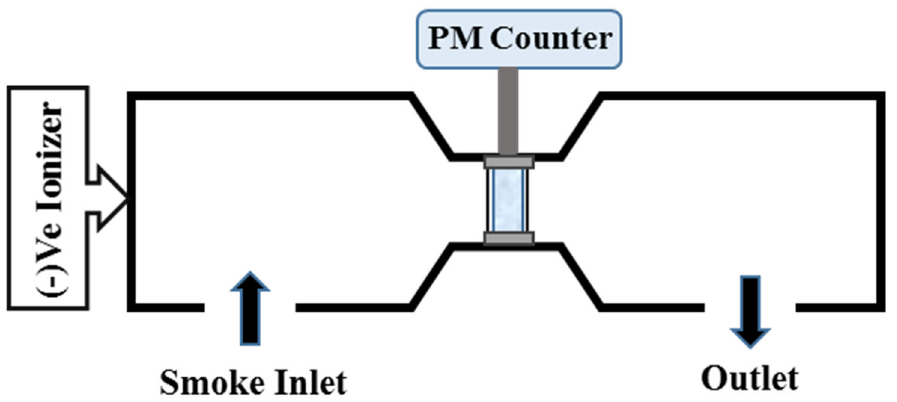
Figure 9. Schematic diagram of PM filtration equipment.